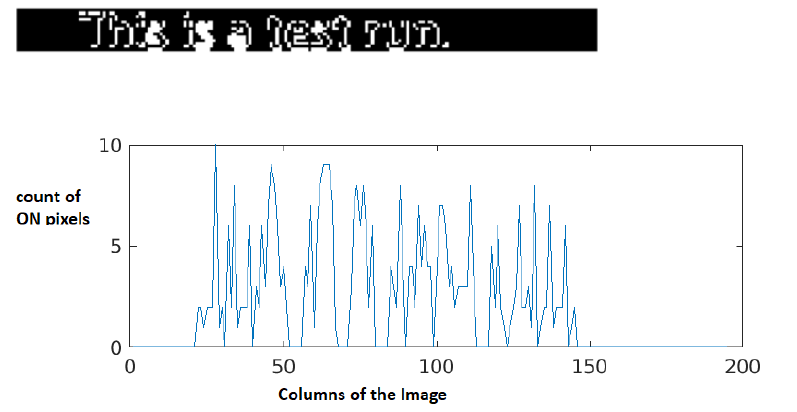
Figure 9. Histogram Projection-Line 1 (whitespaces